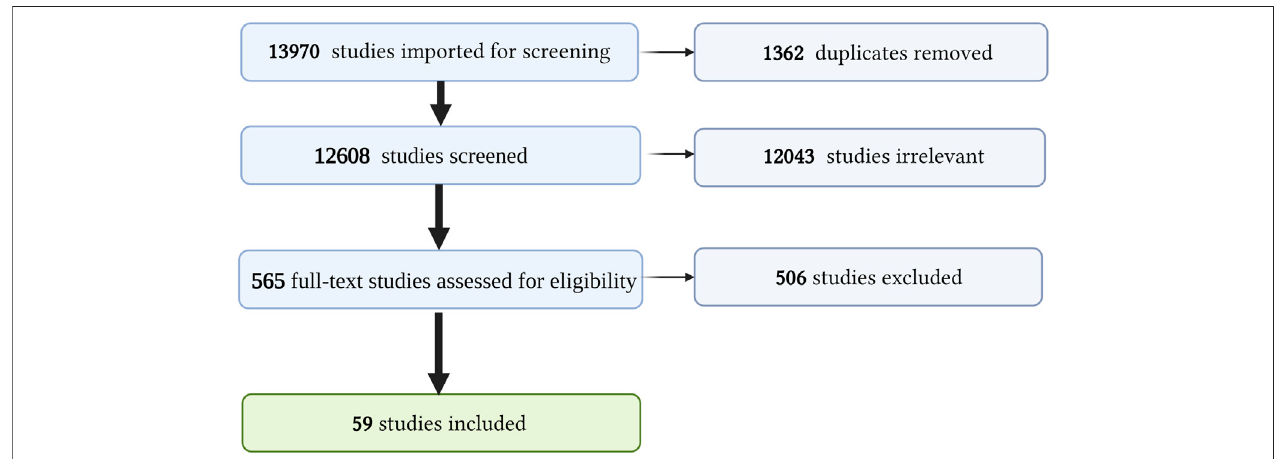
FIGURE 2 | PRISMA diagram. Summary of our systematic review process and screening. Created with